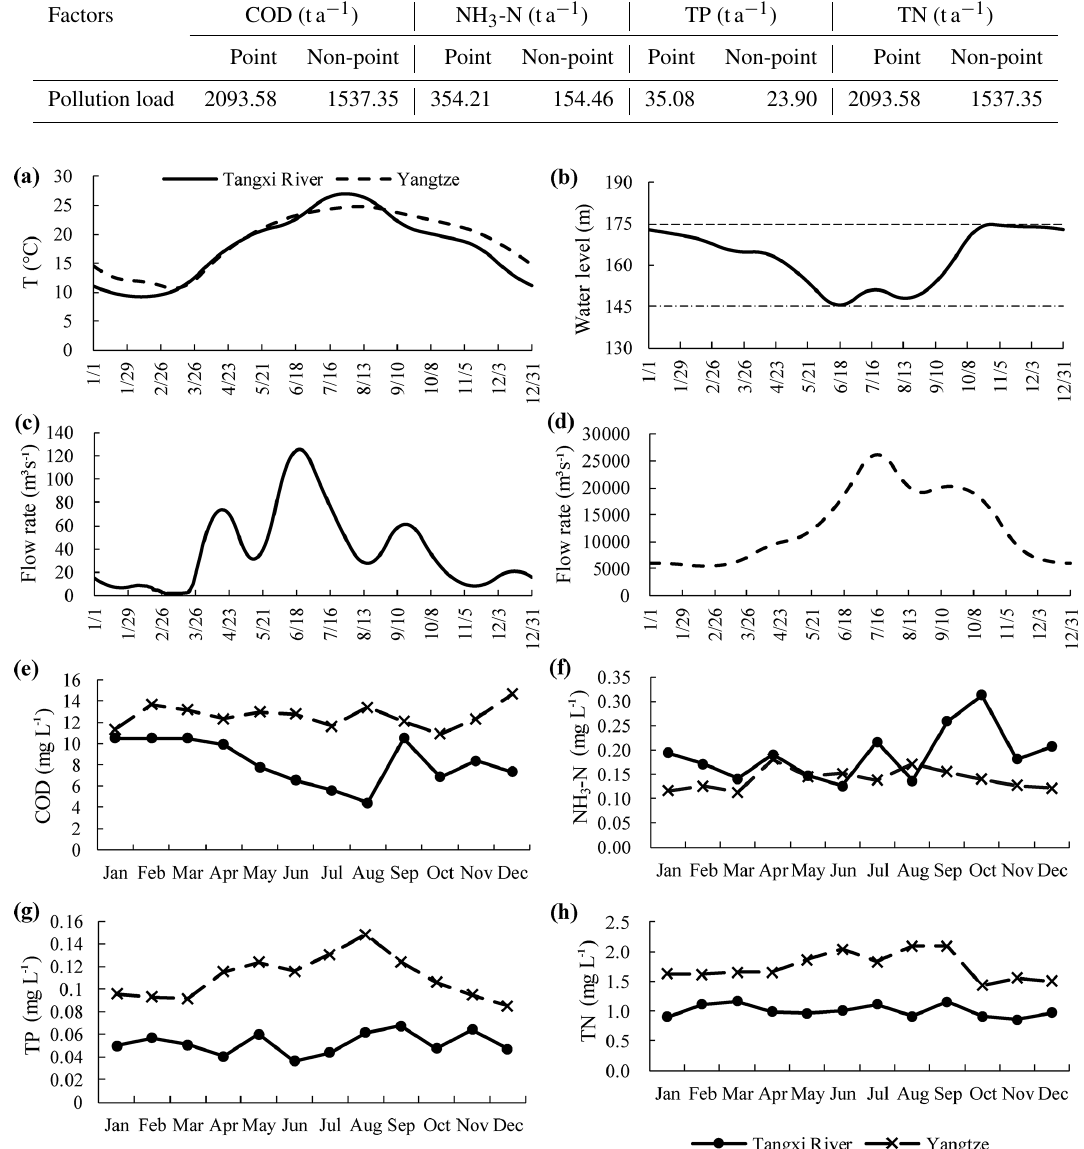
Figure 5. Simulation boundary conditions. (a) Daily water temperatures of the main reservoir and tail of the tributary bay; (b) water level of the main reservoir; (c) daily inflow of the tributary bay; (d) daily inflow of the main reservoir; and (e–h) monthly water quality (COD, NH 3 -N, TP, and TN) of the main reservoir and tributary bay,